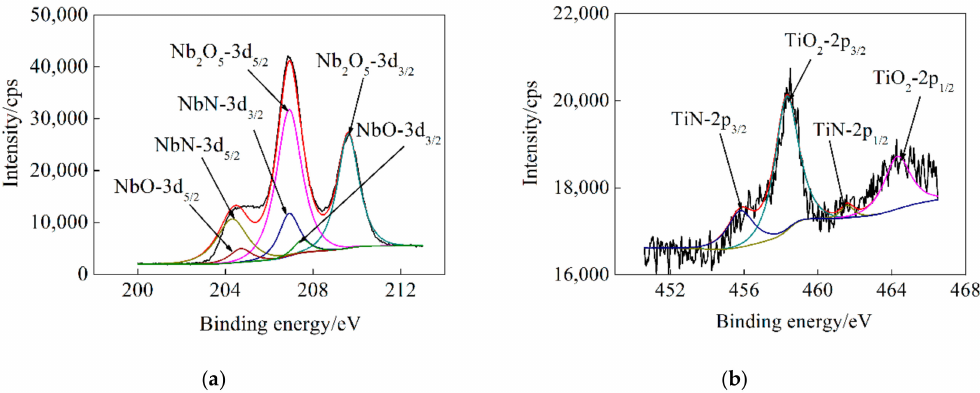
Figure 5. X-ray photoelectron spectroscopy (XPS) spectra of ( a ) Nb 3d and ( b ) Ti 2p (original-black lines, fitted-red lines) measured on TiNbN / 316L